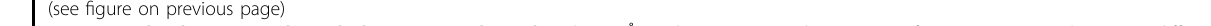
S8c, chromosome misalignment in endogenous CENP-L-de fi cient cells were corrected by wild-type CENP-L but not by DNA binding-de fi cient mutant CENP-L 4E . In CENP-L 4E -expressing cells depleted of endogenous CENP-L, chromosomes failed to align at